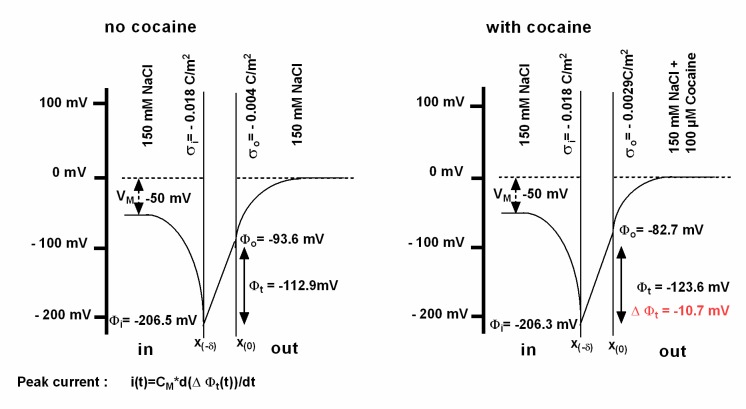
Schematic representation of the voltage across the membrane as predicted from the Gouy-Chapman model.There is a steep increase in (negative) voltage when approaching the membrane from the bulk solution. This is seen on both sides of the membrane and results from the immobilized charges on the inner and outer surface. Ligand binding (i.e. binding of cocaine) induces a change in surface charge density, resulting in a change in the transmembrane voltage (Φt), the magnitude of which is illustrated in the right-hand scheme. This gives rise to a transient current i(t) ("peak current"), which can be calculated from the corresponding equation. The parameters used for the model are provided in Supplementary file 1.